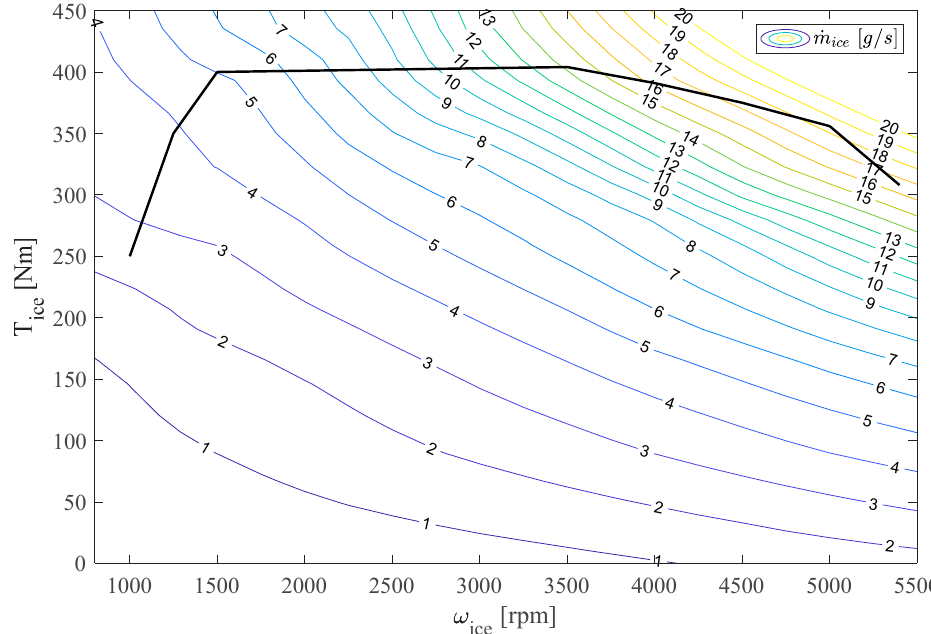
Figure 4. Fuel consumption map of Mazda CX9 2016 internal combustion engine obtained in steady state conditions.